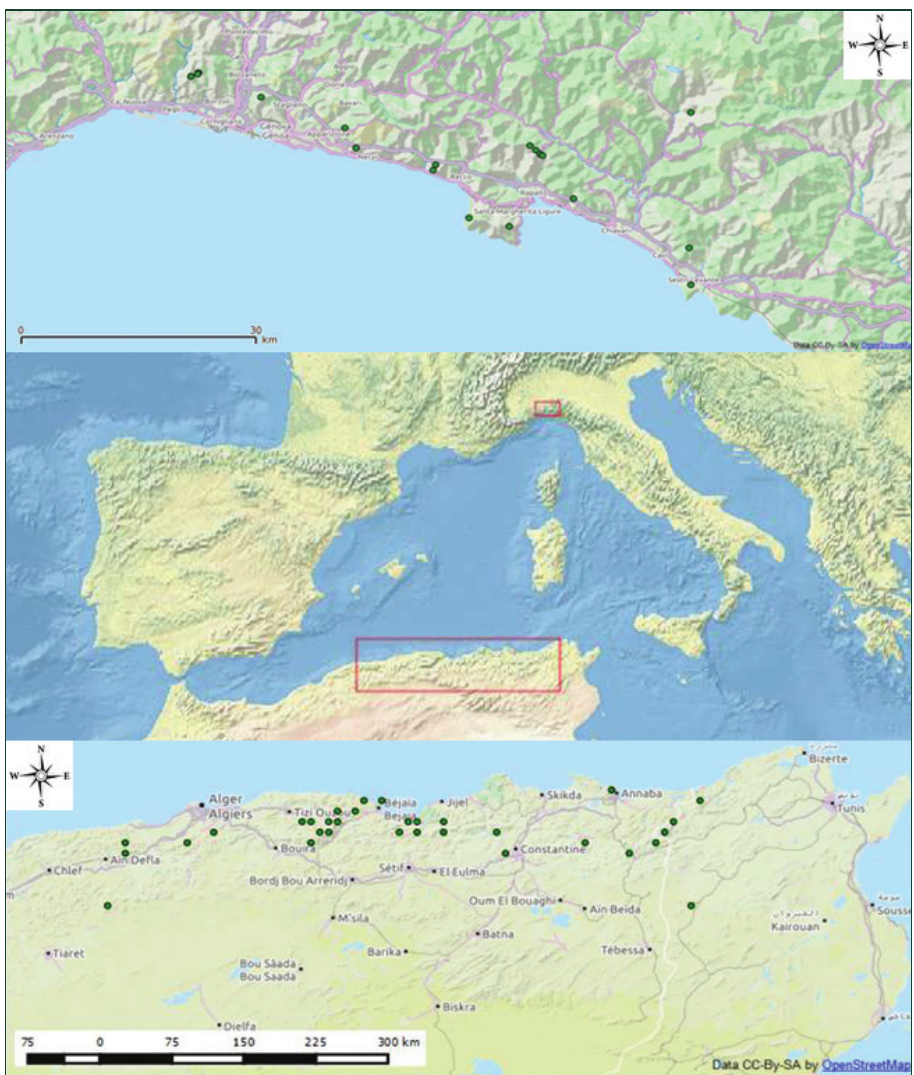
Figure 10. Geographic range and distribution map of Orchis patens subssp. patens . and siliceous substrates. Currently, it occurs both at the edge of cities, in rural areas (in Italy), and in natural environments. Its altitudinal range goes from 100 to 1,700 m a.s.l. Population information: O. patens is usually found at very low densities (less than 20 individuals per site) and is often quite rare. Threats: 1.1 Housing & urban areas: in the past, urban development probably brought O. patens subsp. patens close to extinction in several sites (e.g., Algiers and surroundings) and is an ongoing threat for habitat quality, causing extinction events locally